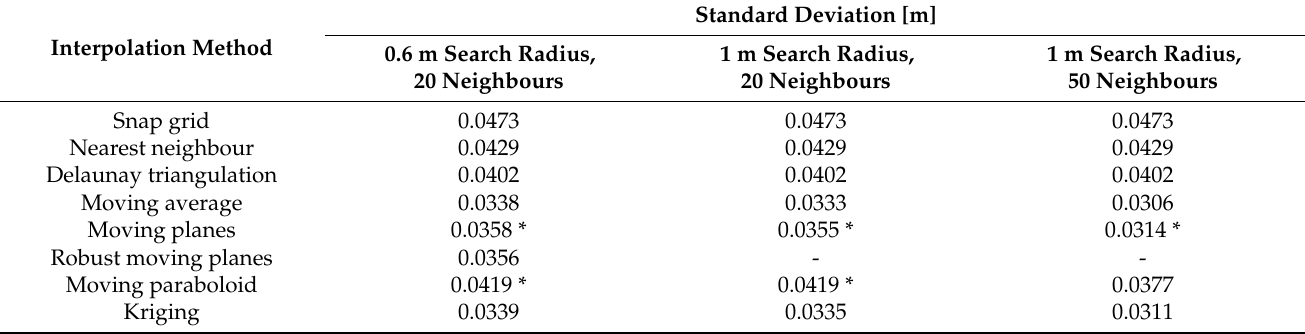
Table 2. Standard deviation for different interpolation methods in three scenarios.